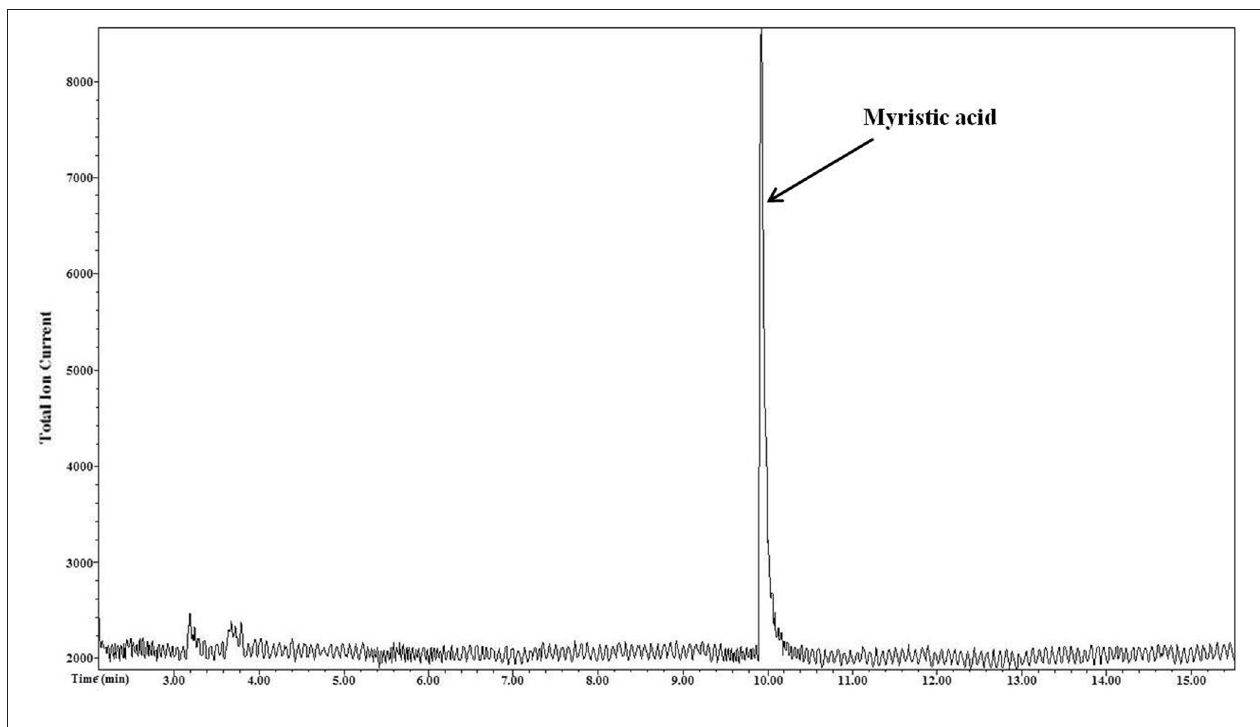
FIGURE 2 | Selective derivatization of NEFA. Myristic acid that was in a non-esterified form underwent derivatization and only the peak of its derivative is seen in the resultant mass chromatogram.